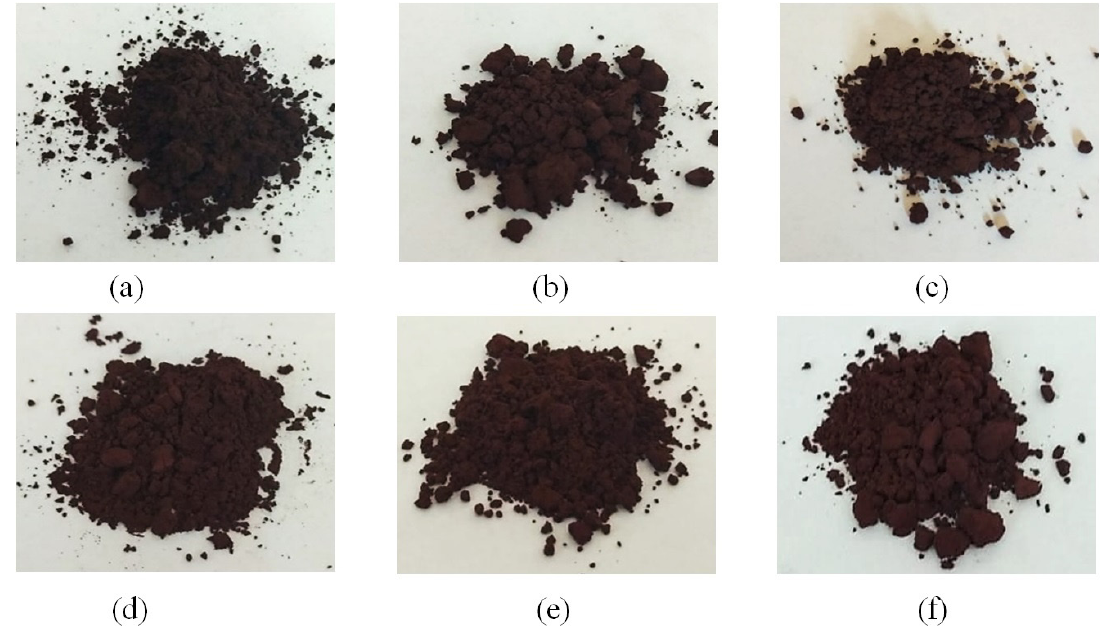
, (B) PAZC33 , (C) PAZC33 , (D) PAZR33 , (E) PAZR33 , and (F) PAZR33 a b c a b